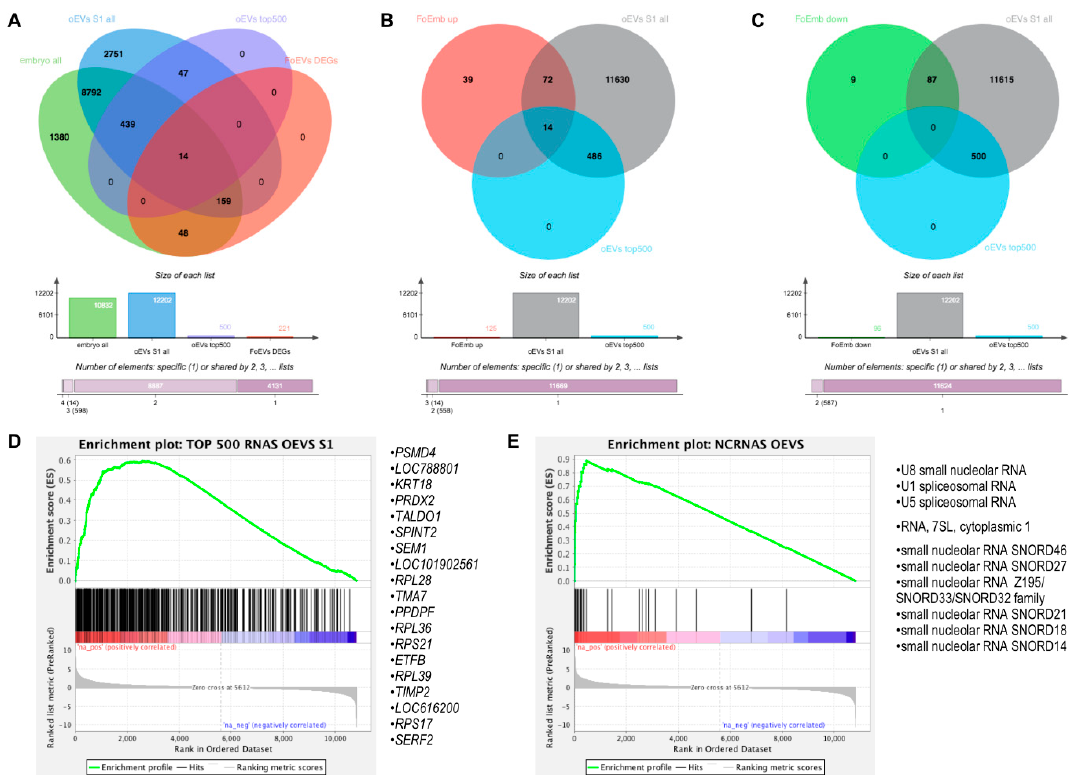
Figure 5. Comparative analysis of embryonic mRNAs altered under oEV treatment and oEV-derived mRNAs and ncRNAs. ( A ) Venn diagrams representing the comparison among all identified mRNAs in embryos, upregulated DEGs in embryos supplemented with frozen EVs (FoEVs) compared to control embryos, all mRNAs in oviductal EVs (oEVs), and top 500 most abundant mRNAs in oEVs; ( B ) comparison among upregulated DEGs in FoEV treatment vs. Co, all mRNAs in oEVs, and the top 500 most abundant mRNAs in oEVs; ( C ) comparison among downregulated DEGs in DEGs in FoEV-treated vs. Co embryos, all mRNAs in oEVs, and the top 500 most abundant mRNAs in oEVs; ( D ) gene set enrichment analysis (GSEA) showing enrichment of the top 500 most abundant mRNAs in oEVs in the rank list of all genes detectable in embryos supplemented with frozen oviductal EVs (oEVs) ranked by differential expression (red = higher expression in FoEVs-treated embryos compared to control embryos, blue = lower expression), and the 19 genes with the highest enrichment scores; ( E ) GSEA enrichment plot showing enrichment of oEVs-derived non-coding RNAs (ncRNAs) in the rank list (same list as in D), and the 10 ncRNAs with the highest enrichment scores.